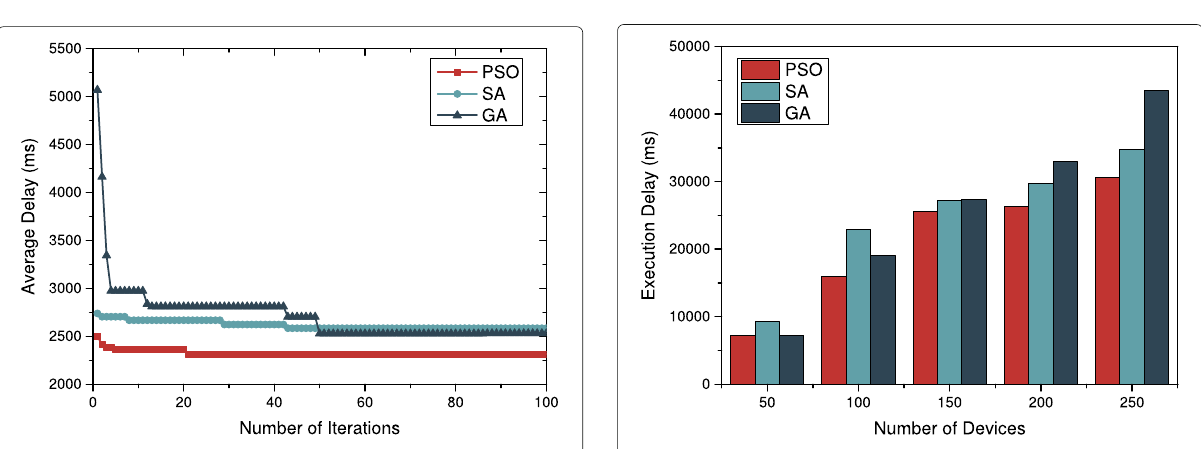
Fig. 9 Comparison of the execution delay of the three offloading strategies under different number of